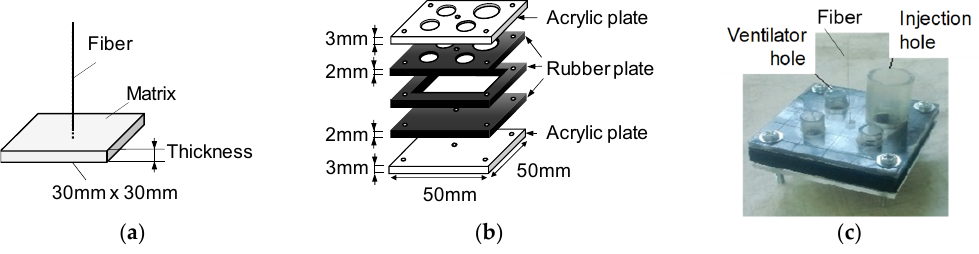
Figure 2. Pullout specimen: ( a ) Dimensions of pullout specimen; ( b ) Constitute of mold; ( c ) Example of mold.